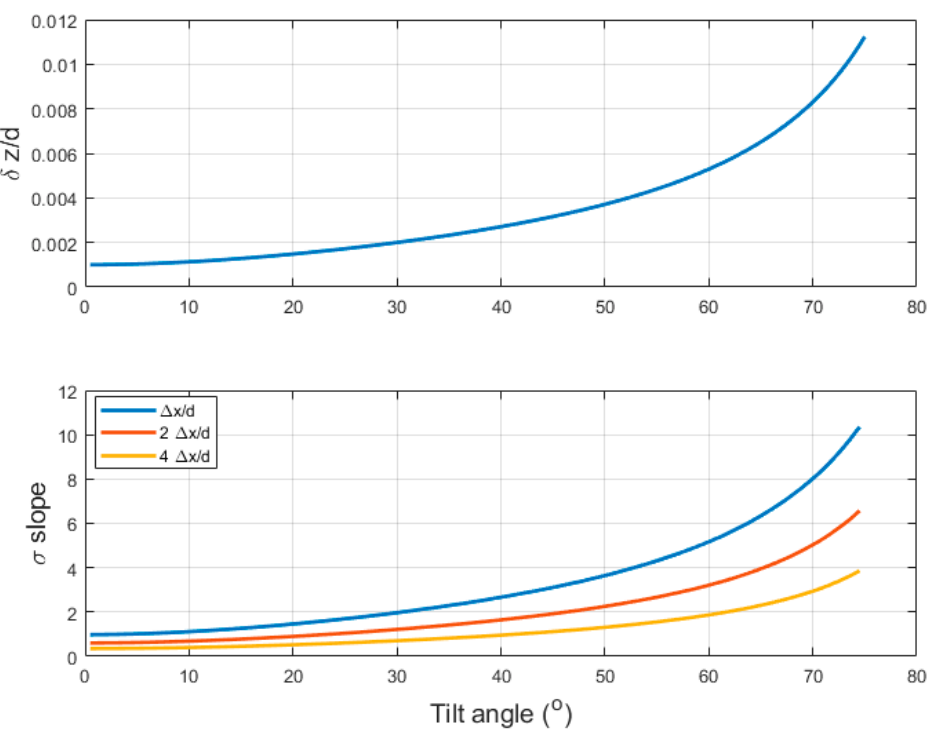
Figure 18. Typical angle-dependent depth uncertainty ( top ) for a modern shallow water MBES, and uncertainty in slope ( bottom ) using Equation (10) with sounding spacing ( ∆ x ) defined by equidistant beams (160 beams) spread over a 75 ◦ angular swath. Horizontal uncertainty (HorU) is assumed to be 0.1 m in this simulation.